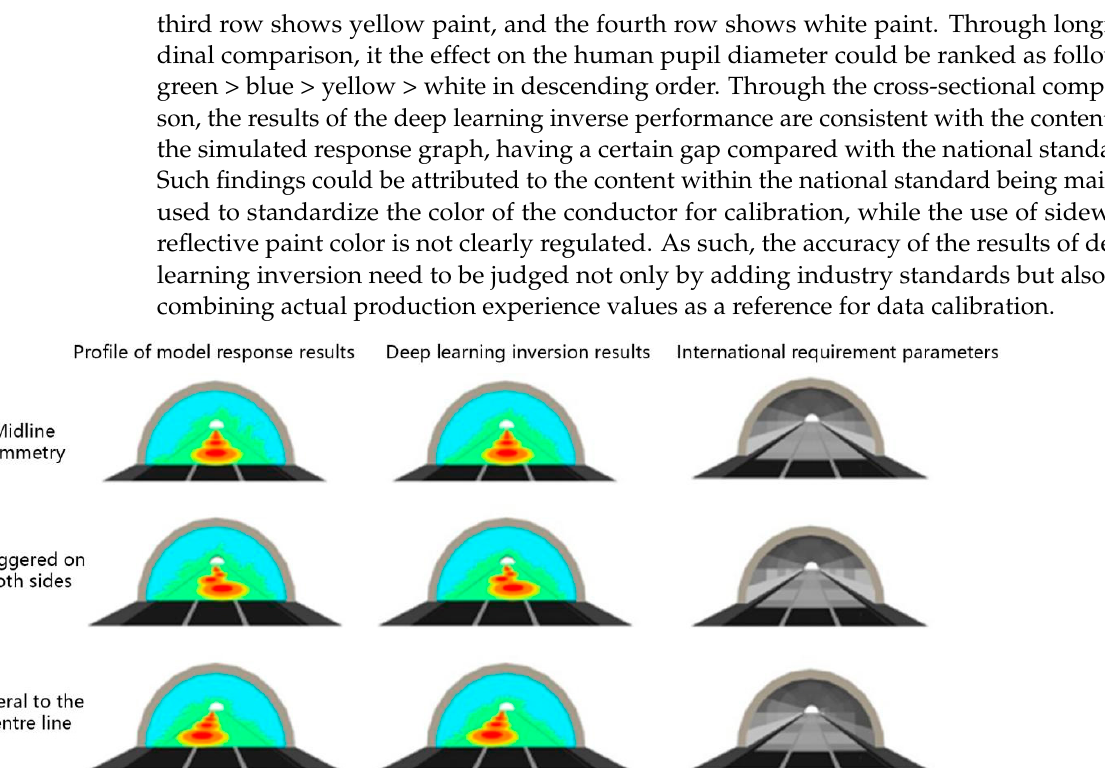
Table 10. Table of influence degree of the side wall reflective paint color and pupil diameter.